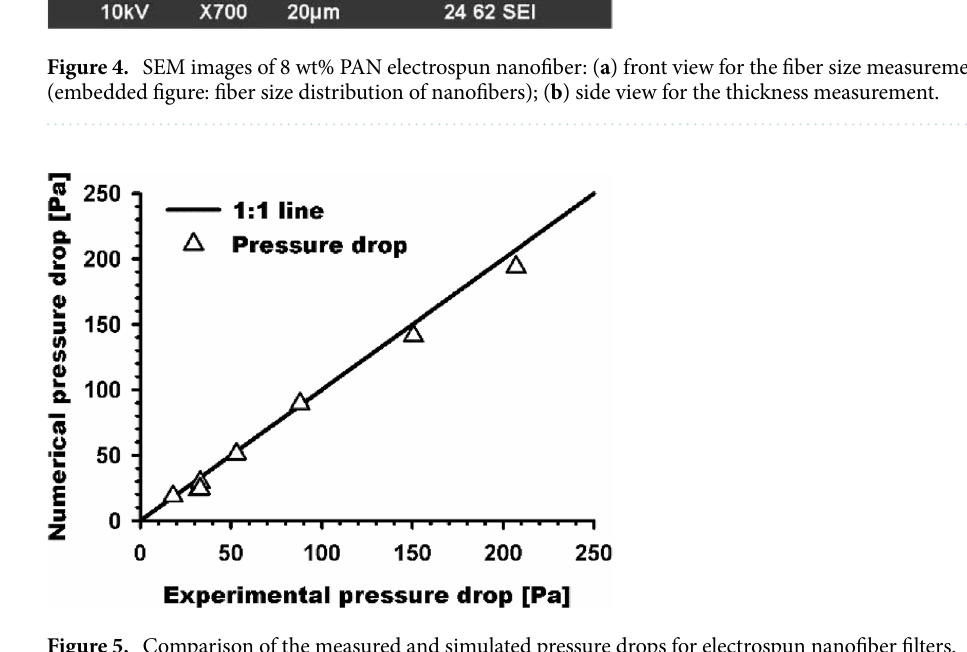
Figure 5. Comparison of the measured and simulated pressure drops for electrospun nanofiber